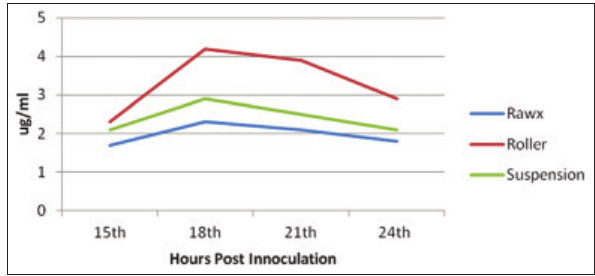
Figure-6: Effect of cell culture systems on foot and mouth disease virus serotype (SAT-2) antigenicity (146S content) in baby hamster kidney-21 cell line at 37°C.